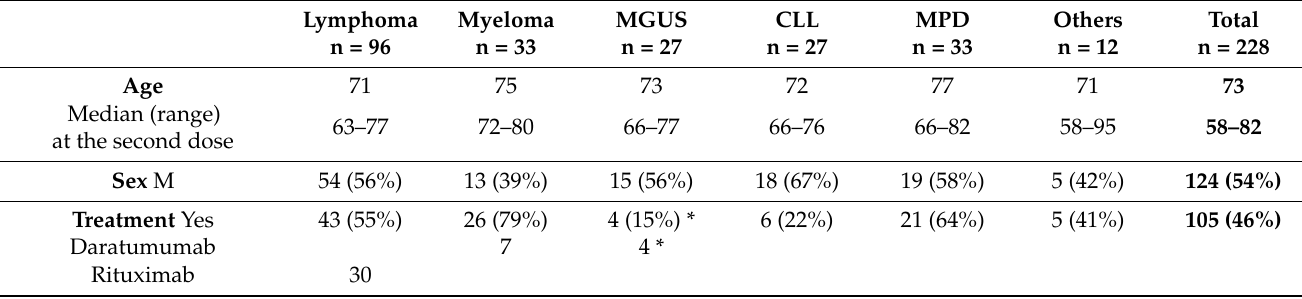
Table 1. Patients’ characteristics for the different groups of diseases, number of patients seroconverted and median (range) levels of the anti-spike anti-antibodies, significantly different between patients with hematological malignancies (HMs) and patients with non-malignant hemopathy. Abbreviations: MGUS: monoclonal gammopathy of undetermined significance; CLL: chronic lymphocytic leukemia; MPD: myeloproliferative